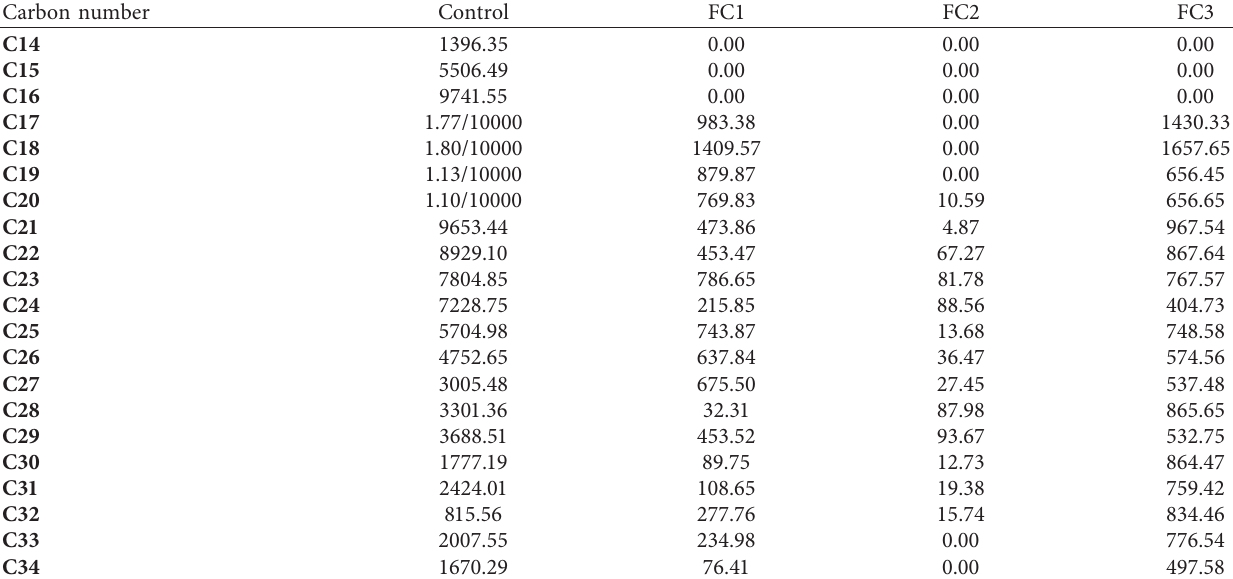
Table 3: Quantitative degradation analysis, estimated by GC, of saturated hydrocarbons using three fungal consortia corresponding to untreated control. FC1 = mixed culture of Penicillium chrysogenum and Curvularia brachyspora , FC2 = mixed culture of Scopulariopsis brevicaulis and Stemphylium botryosum , and FC3 = mixed culture of Scopulariopsis brevicaulis , Stemphylium botryosum, and Cladosporium sphaerospermum